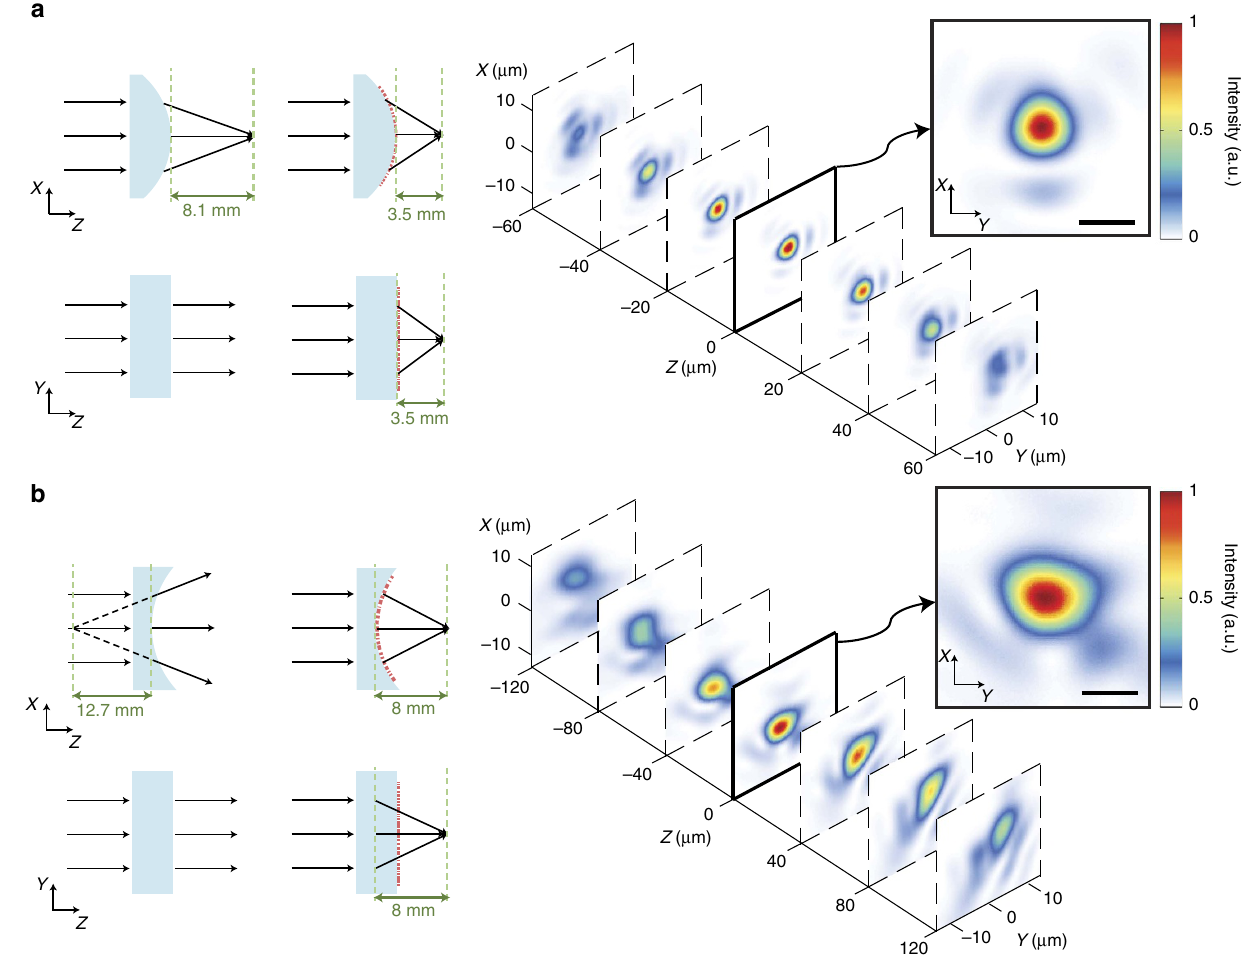
Figure 4 | Measurement results of conformal dielectric metasurfaces. ( a ) A converging cylindrical lens with a radius of 4.13mm and a focal distance of 8.1mm is optically modified using a conformal metasurface with a diameter of 1mm. The cylinder plus the metasurface combination behaves as an aspherical lens with a focal length of 3.5mm. The coordinate system is the same as in Fig. 2. ( b ) A different metasurface is mounted on a concave glass cylinder with a radius of 6.48mm and a focal distance of (cid:2) 12.7mm, which makes it focus to a spot 8mm away from its surface (as an aspherical lens). Schematic illustrations (side and top views) are shown on the left, and intensities at planes parallel to the focal plane and at different distances from it are shown on the right. Intensities at the focal plane are depicted in the insets. Measurements are performed at the wavelength of 915nm. For the measurement details see the ‘Methods’ section. Scale bar, 5 m